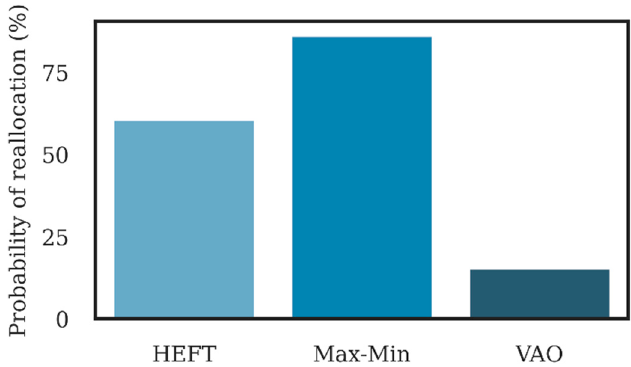
Figure 7. Probability of task reallocation.